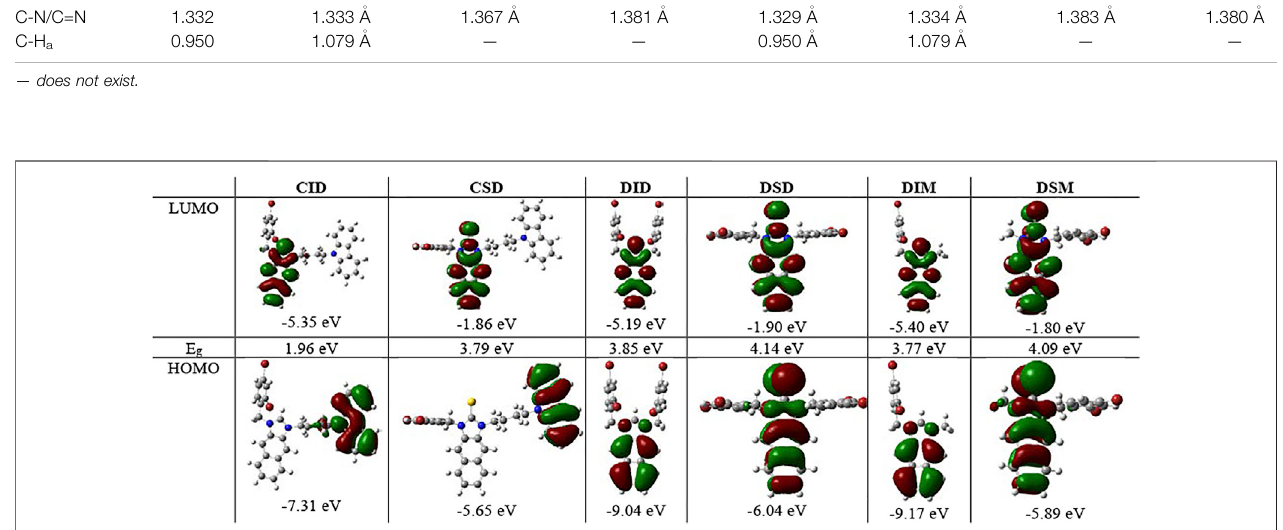
Frontiers in Chemistry |